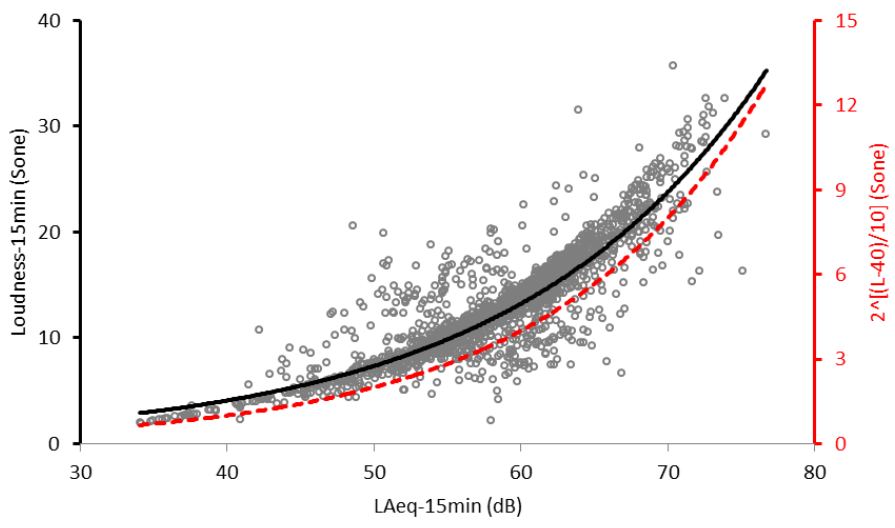
Figure 12. Scatter-plot of the L Aeq-15min scores vs. the Loudness -15min scores (black line), compared with the theoretical formulation by Fastl and Zwicker [17] (red dashed line).